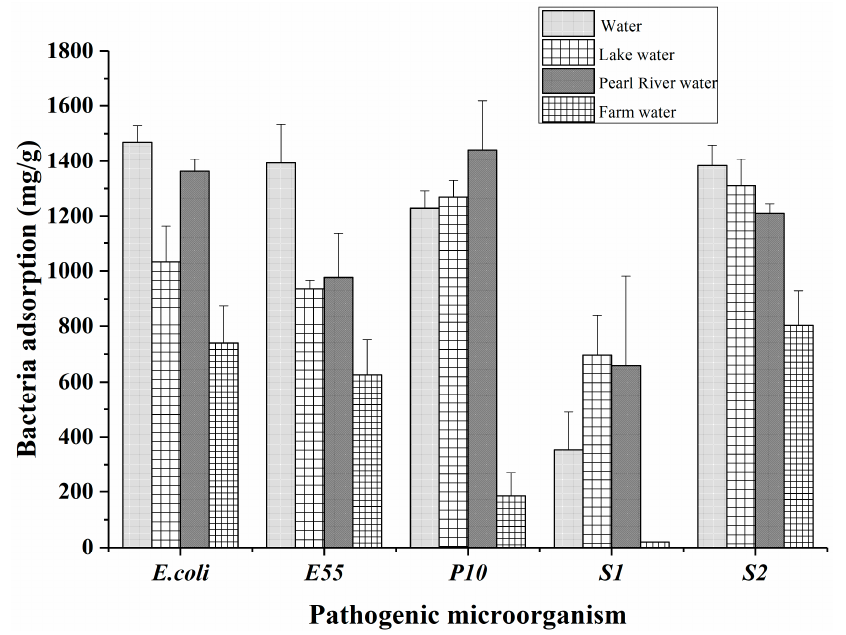
Figure 6. Adsorption of different bacteria by SiO 2 @NH 2 @COOH@CST in tap water, lake water, Pearl River water, and farm water. E55 , P10 , S1 , and S2 represent E . coli , Pseudomonas aeruginosa ( P . aeruginosa ), Salmonellae , and Staphylococcus aureus ( S . aureus ).